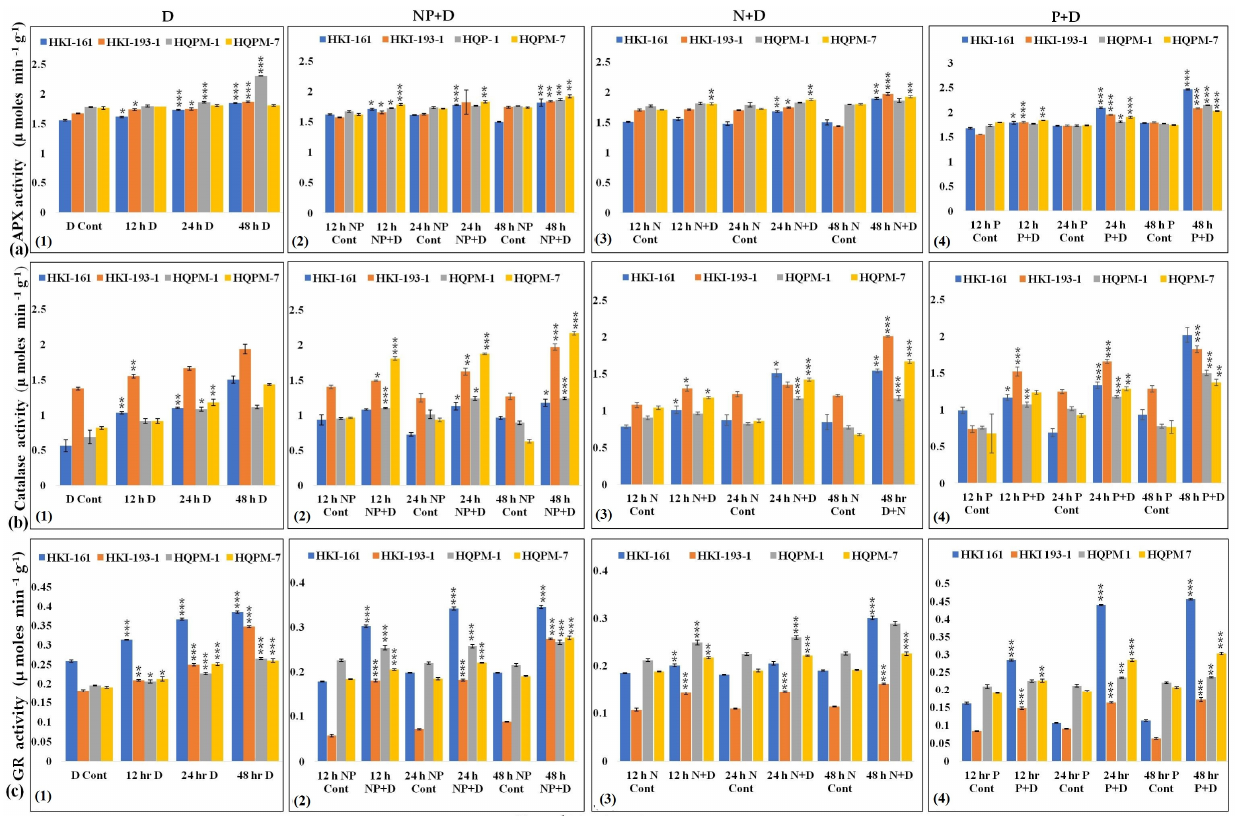
Figure 6. Changes in the ( a ) ascorbate peroxidase (APX), ( b ) catalase (CAT) and ( c ) glutathione reductase (GR) activity of four maize genotypes subjected to drought stress (D) alone and with Nitrogen (N) and/or Phosphorous (P) pre-supplementation. Subfigures show the respective response under drought stress ( 1 ) without nutrient pre-supplementation, ( 2 ) pre-treatment with NP, ( 3 ) pre- treatment with N and ( 4 ) pre-treatment with P. Bars represent the standard error of the mean among the three biological replicates. Asterisks indicate significant statistical differences: *** p < 0.001, ** p < 0.01, * p <